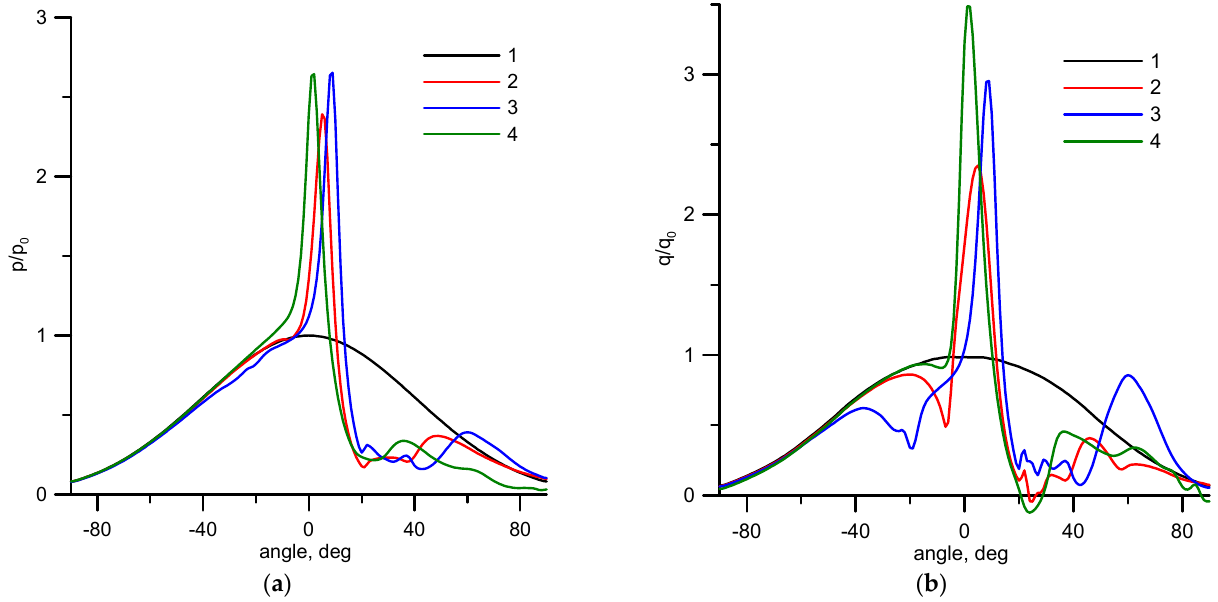
Figure 8. Distributions of pressures ( a ) and heat fluxes ( b ) along the surface at successive times for variant 2 with two particles. 1—initial moment, 2—0.3 ms, 3—0.38 ms, 4—0.69 ms .